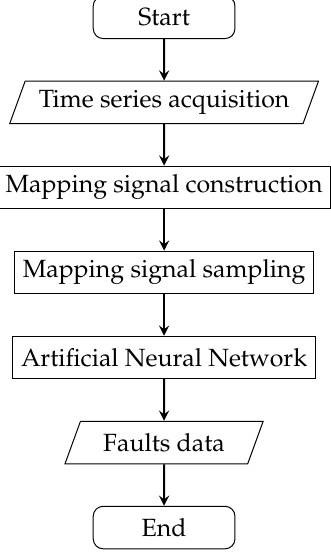
Figure 1. Prognostics algorithm